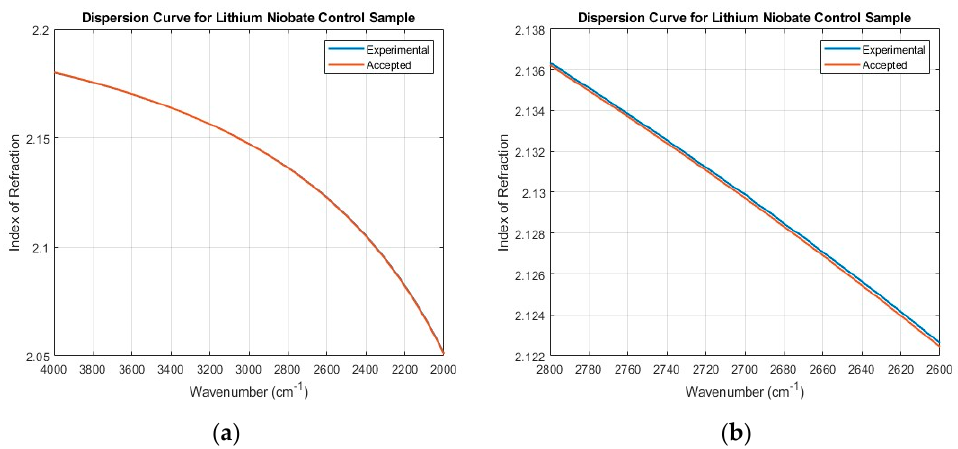
Figure 15. A comparison of the calculated refractive index values to literature values for the lithium niobate control sample. ( a ) full-view; ( b ) zoomed-view to show differences.